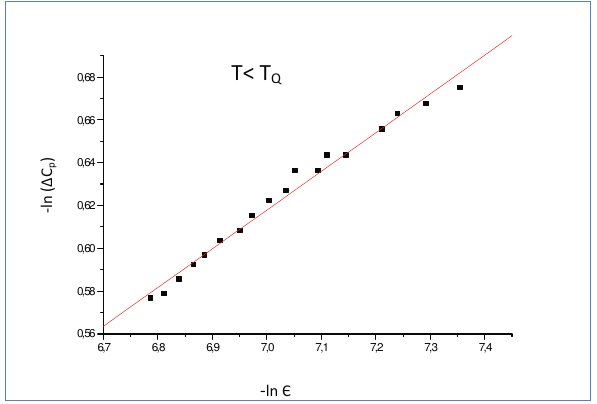
Figure 7. The specific heat (cid:3)C P as a function of the re- duced temperature ( (cid:4) D j T (cid:2) T Q j =T Q / below the transi- tion temperature ( T Q D 577:1 ı C) for the ˛ - ˇ transition in quartz according to Eq. (2). The specific heat C P data [2] was analyzed along the cooling curve. (see Table 4).